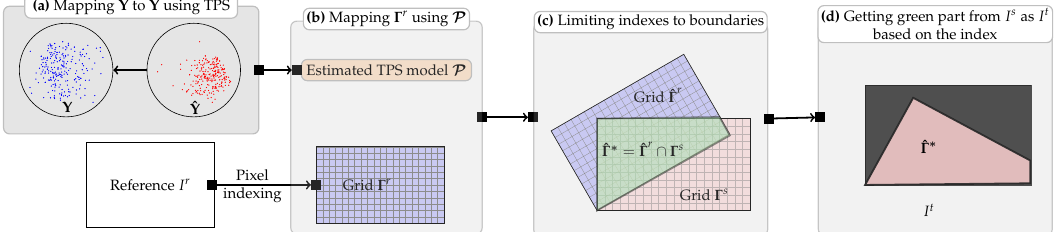
Figure 6. Illustration of the image transformation and resampling. ( a ) Computing a TPS transformation model P which maps ˆY back onto Y , meanwhile, constructing a grid Γ r which is of the same r size as I r ; ( b ) Mapping Γ r using P , obtaining ˆ Γ ; ( c ) Limiting indexes to boundaries of ˆ Γ r ∩ Γ s